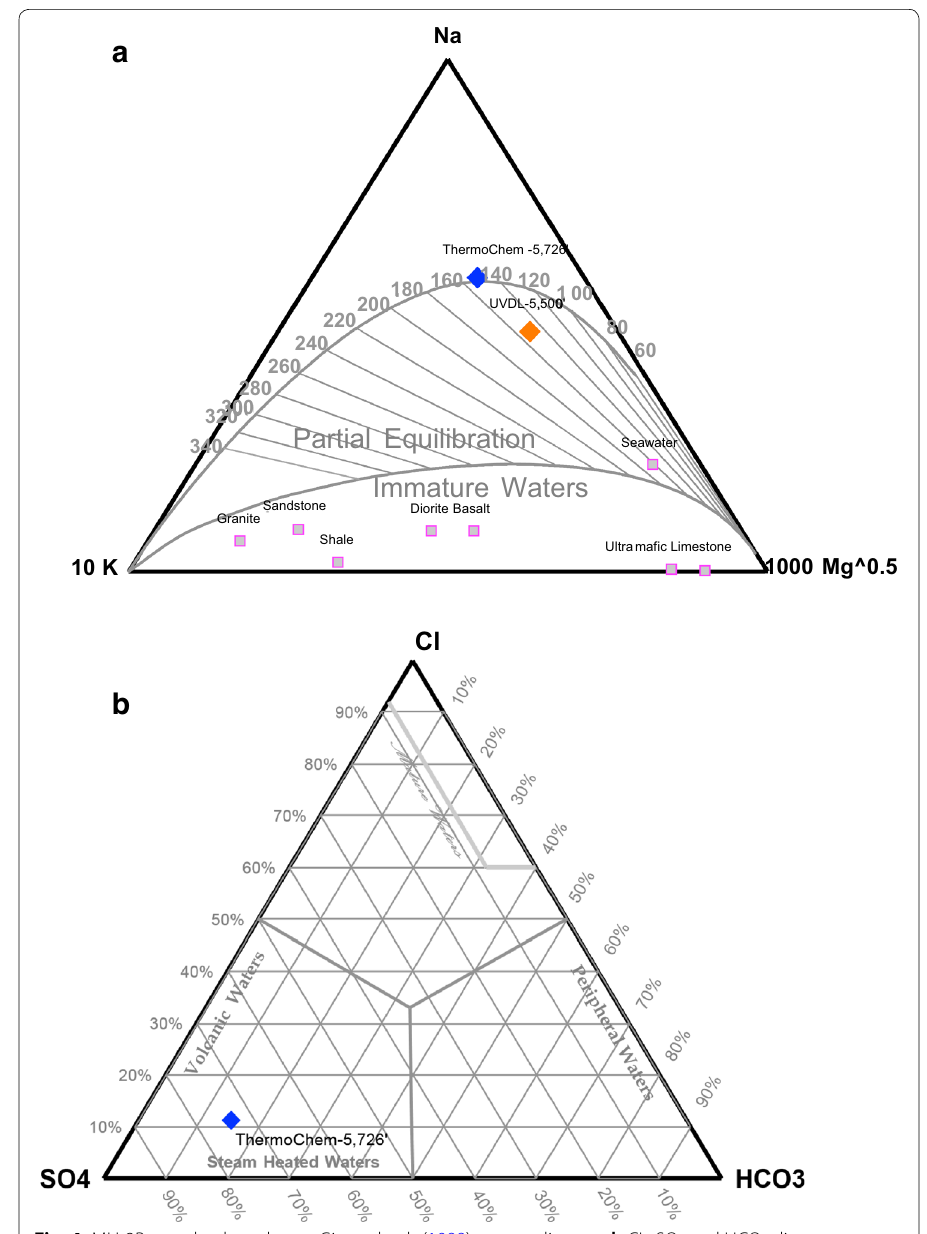
Fig. 4 MH‑2B sample plotted on: a Giggenbach (1988) ternary diagram; b CL, SO 4 and HCO 3 diagram (Giggenbach 1988)